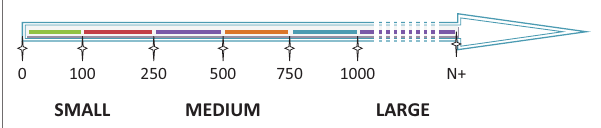
FIGURE 1: A generic congregation size scale. Source : Adapted from Fish, T., 2006, Church size , viewed 30 October 2013, from http://www.